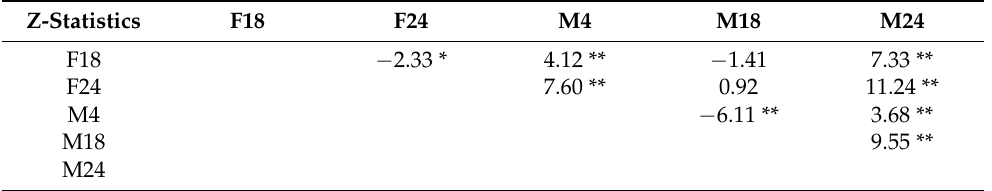
Figure 3. Violin plots showing the probability density of the heights above ground level (Y-axis) of the GPS points of each lesser kestrel. The box plots inside the violin plots show median (horizontal line inside the box) and the 25–75 percent quartiles. IDs are the same as those in Table 1. Table 2. Pairwise comparisons between the statistical distributions of bird heights above ground level by using a two-sample z-test. The table shows the pairwise z-values along with statistical significance. Tests were considered to be significant for (two sided) p < 0.05.